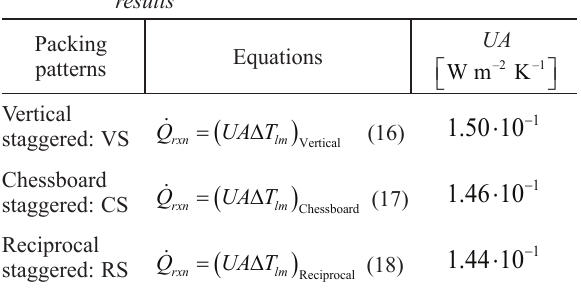
Table 4 – Summary of the overall heat transfer coefficient results